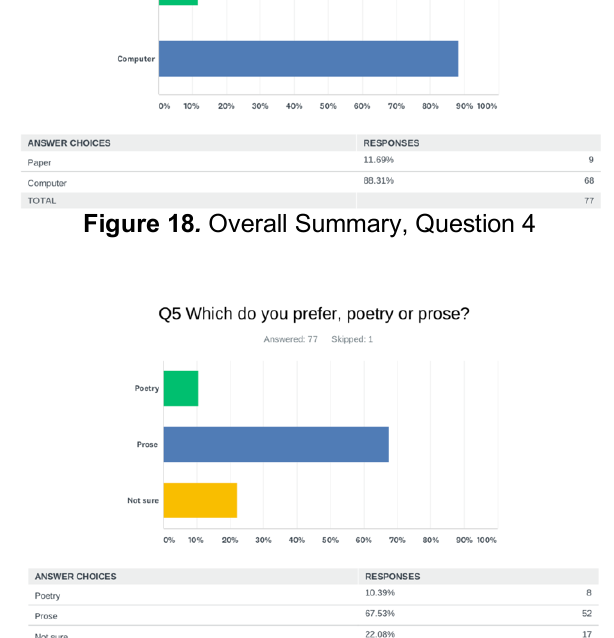
Figure 19 . Overall Summary, Question